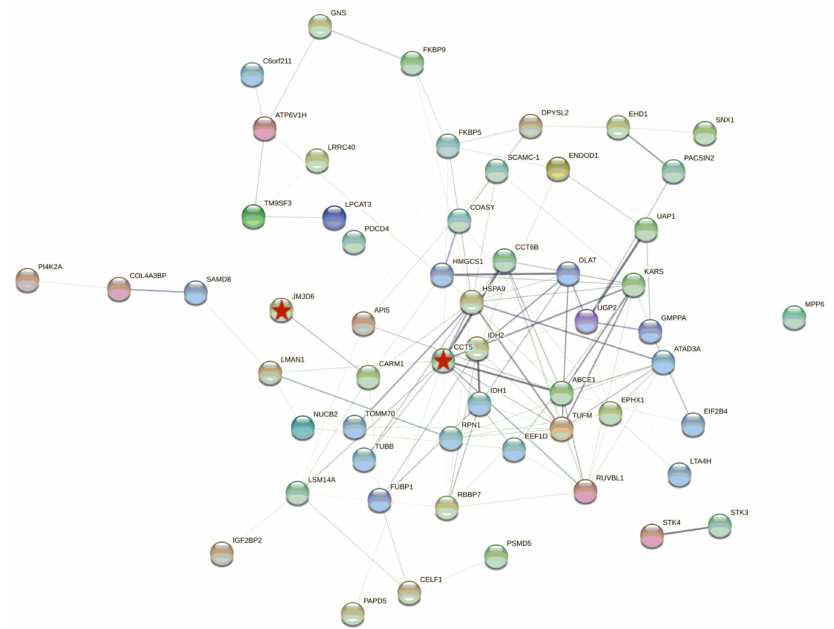
Figure 2. The protein-protein interactions (PPIs) network analysis using STRING database. The linkers indicate associations of function and physical protein. The thickness of line indicates the strength of correlation (PPI enrichment p value < 0.05). Proteins represented have been named as NCBI gene names. JMJD6 and CCT5 were marked with Stars.